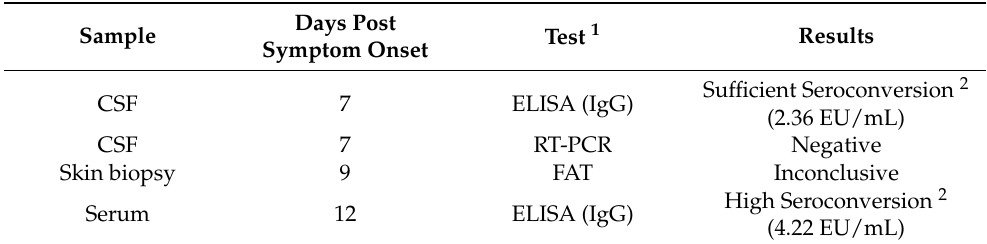
Table 2. Laboratory tests performed for samples collected from a 37-year-old male with clinical suspicion of